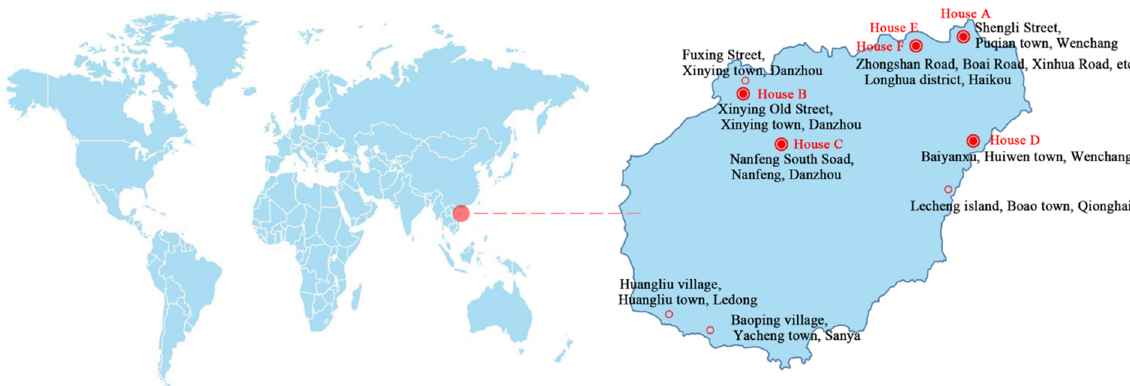
Figure 3. LSH distribution in Hainan Island.